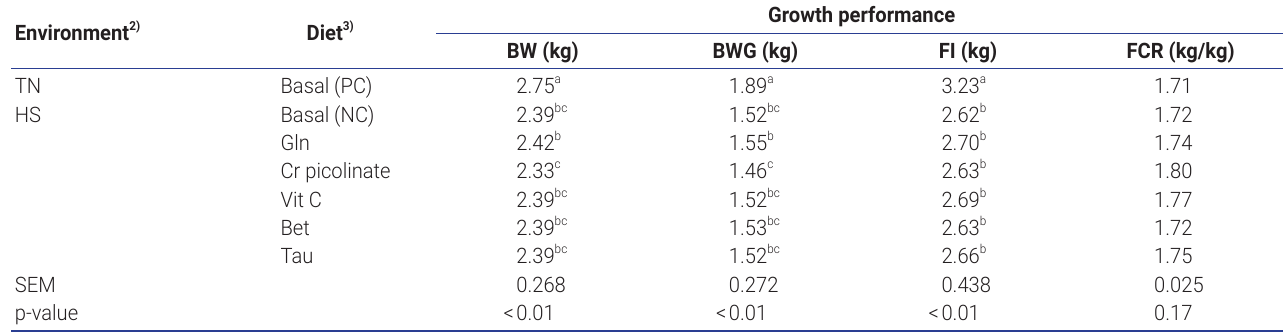
Table 2. Effects of dietary supplementation of various functional nutrients on growth performance of broiler chickens raised under heat stress conditions 1)